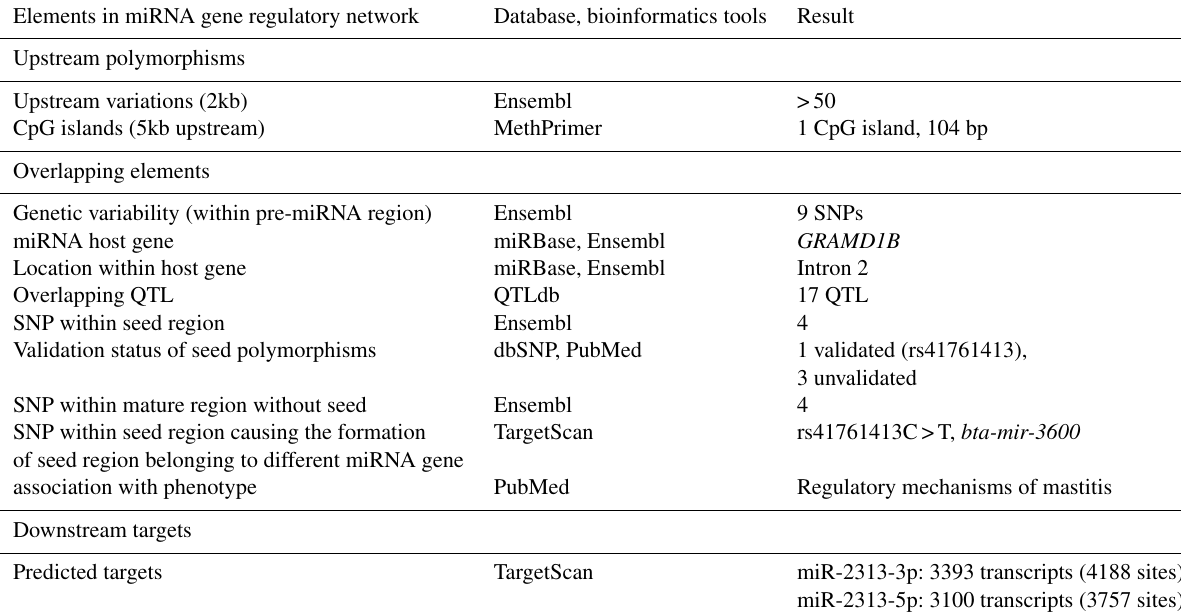
Table 1. Summary of the collected genomic information associated with the miRNA gene bta-mir-2313